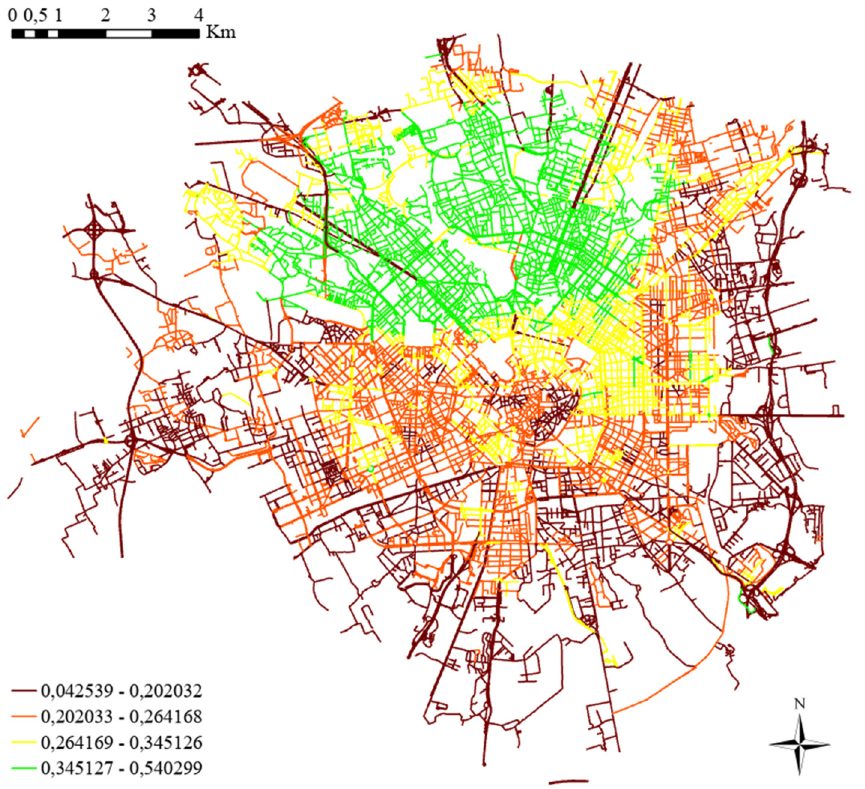
Figure 6. Final map of the city of Milan with the indication of Feasibility Index.